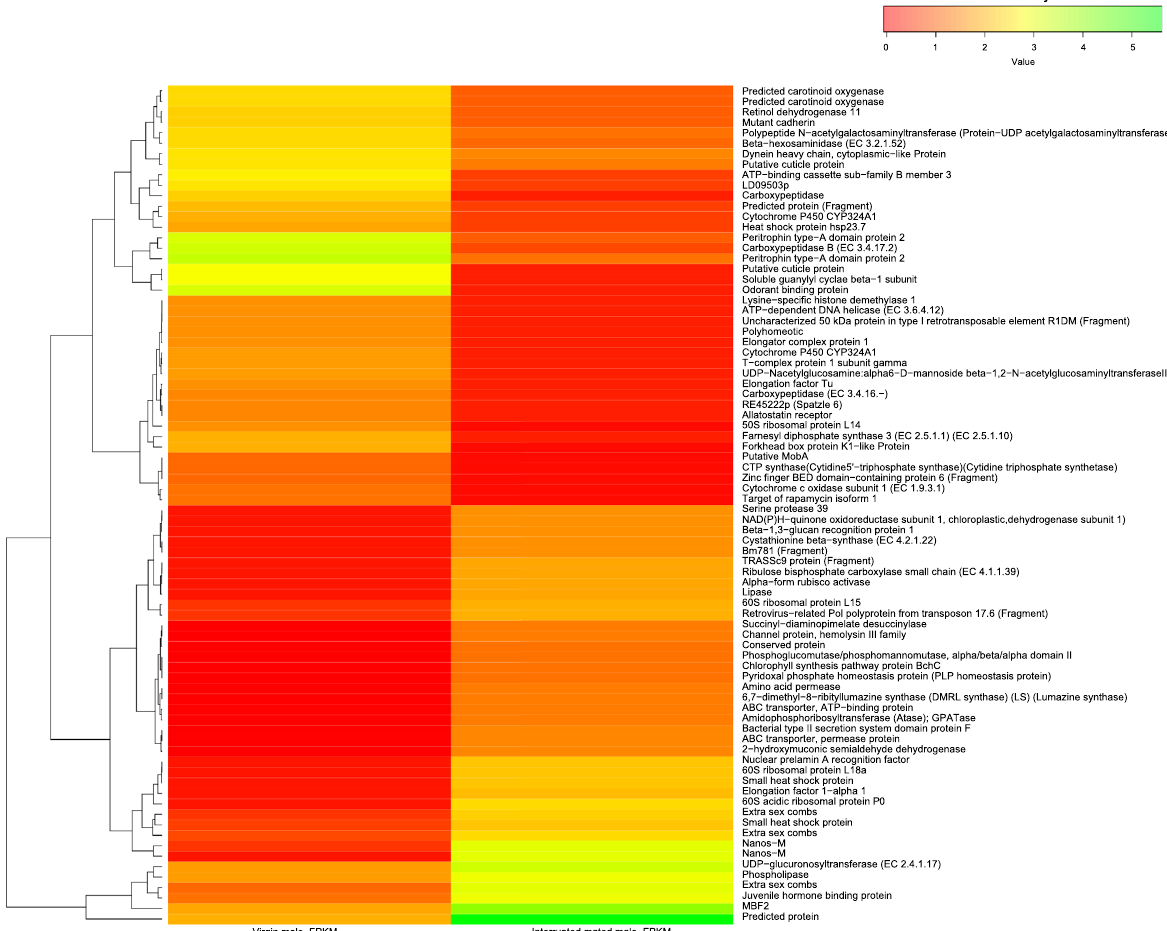
Fig. 3 Heat map of top 80 differentially expressed transcripts across virgin males and males interrupted during mating. Red colour indicates down-regulated expression and green indicates up-regulated